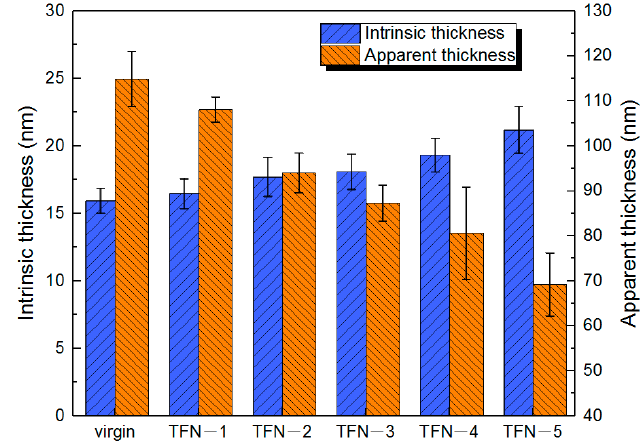
Figure 5. SEM and TEM micrographs of the top surface and cross-section for TFC and TFN mem- branes with different ODA@GO nanosheet loadings: ( a , d , g , j ) TFC (0%, w / v ), ( b , e , h , k ) TFN － 2